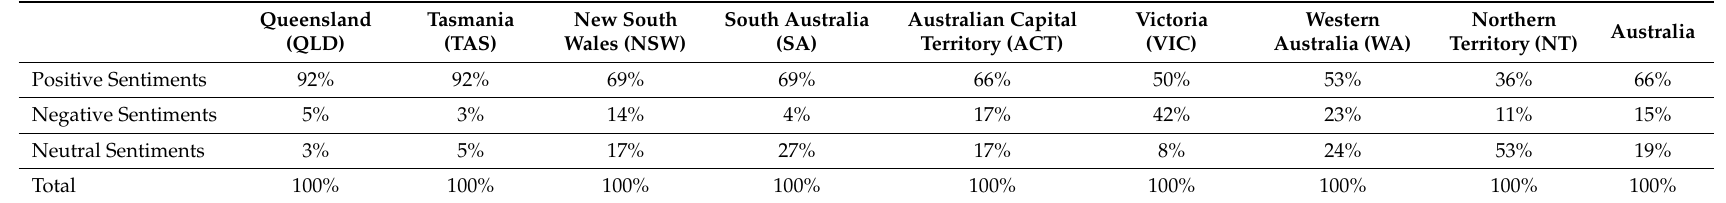
Table 1. Tweet sentiments in percentages per state / territory.